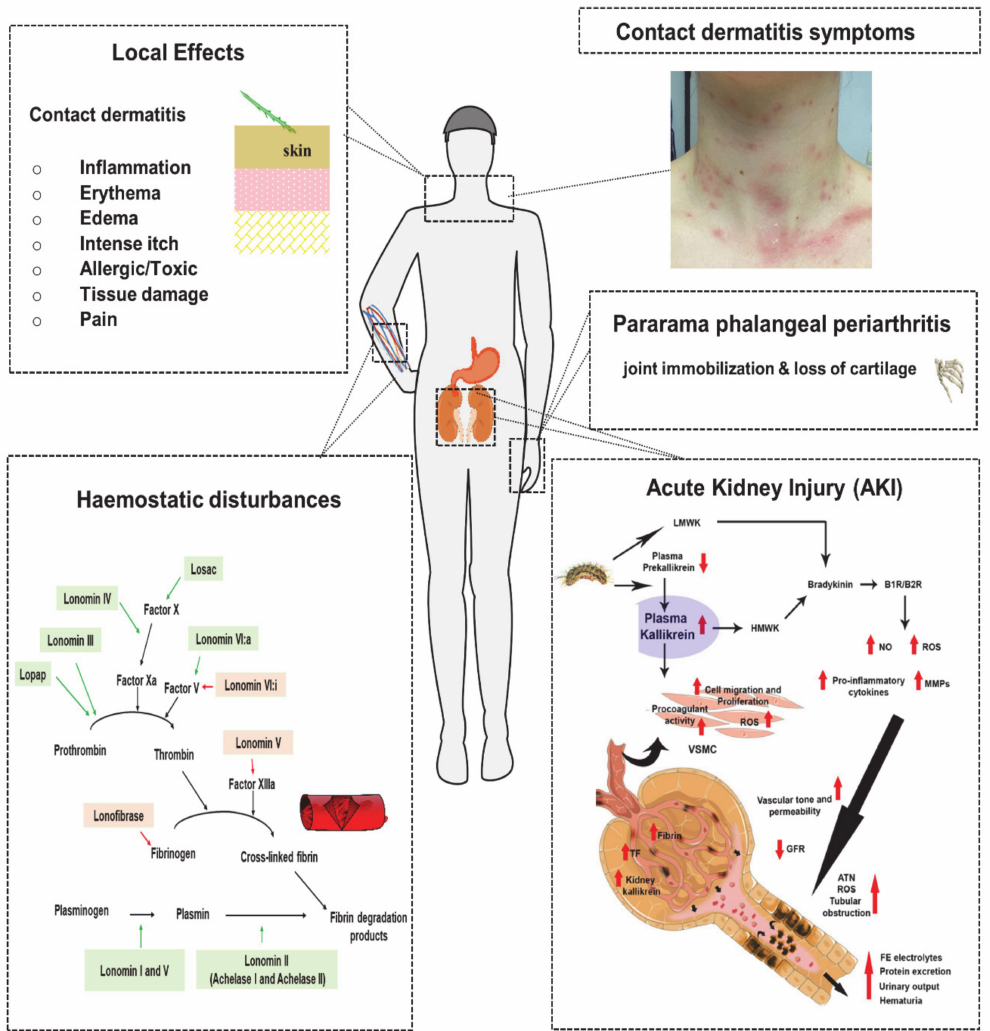
Figure 4. Venom components of di ff erent caterpillar species and their role on human body targets in the pathophysiology. Caterpillar venoms contain pharmacologically active components that are able to interfere with targets in the normal human cellular physiology. Some components are responsible for the local e ff ects such as inflammation, erythema, edema, intense itch, tissue damage, pain and may exert an allergic reaction. Others a ff ect the hemostasis by acting on the coagulation cascade or on the fibrinolytic pathway. Venom components colored in green activate a step in the cascade, while the components colored in red are able to inhibit a step. In some cases, this can lead to the development of an acute kidney injury (AKI). The venom-induced AKI cascade in the figure is copied with permission from